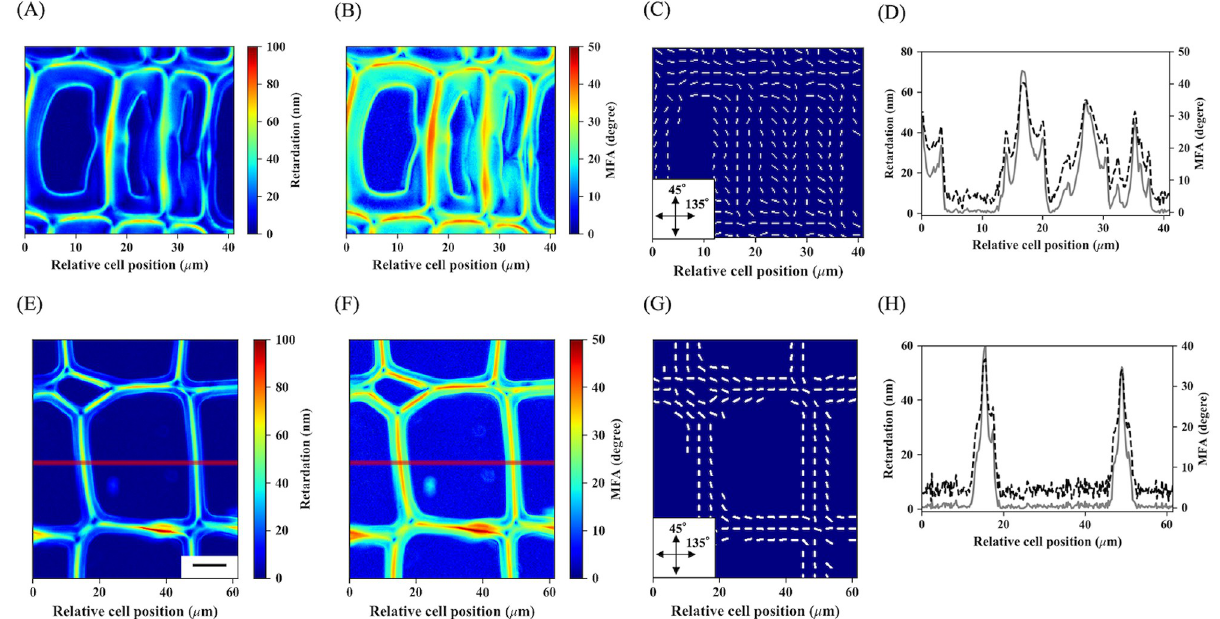
Fig 4. Examples of retardation, microfibril angle (MFA), and azimuthal angle images. (A–C) Retardation, MFA, and azimuthal angle images of latewood tracheids. (E–G) those of earlywood tracheids. (D) and (H) Sectional views of retardation (grey solid line) and MFA values (black dotted line) along red lines drawn on latewood tracheids (A and B) and earlywood tracheids (E and F). In (D) and (H), the S 2 and S 1 +S 3 layers appear as local- intensity minima and maxima, respectively. Bars, 10 μ